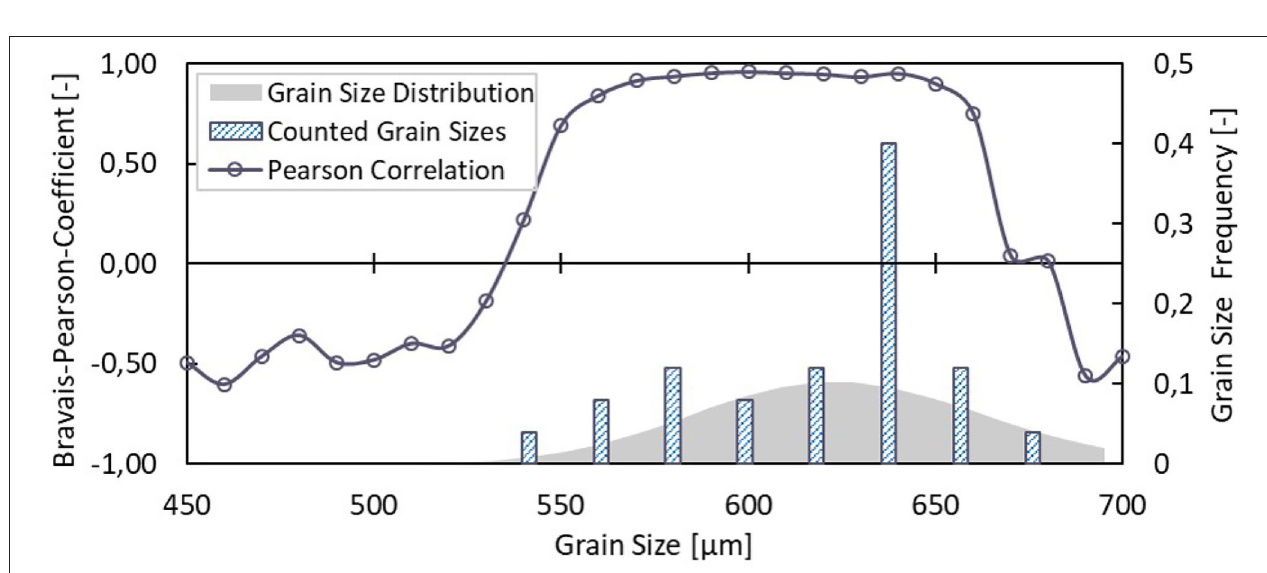
FIGURE 7 | Pearson correlation coefficient (see Equation 10) as a function of grain size. The gray colored area and the histogram illustrates the grain size distribution calculated from the grain sizes measured by snow microscopy (see Figure 5 ). For each grain size, the fractional contact areas between grain and ski sole topographies is calculated and a Pearson correlation coefficient is determined (see Figure 6 which shows this relation exemplary for some grain sizes).